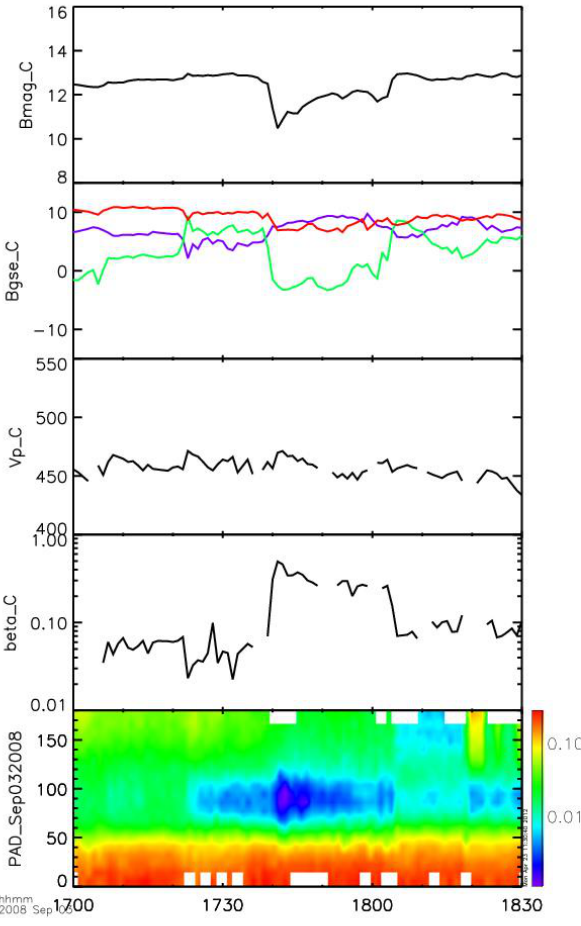
Fig. 3. ACE observation: zoom-in around the 90 ◦ pitch angle deple- tion. The panels give from top to bottom (a) magnetic field magni- tude, (b) magnetic field components in GSE, (c) solar wind speed, (d) plasma beta, and (e) the electron pitch angle spectrograms for the low-energy Electron Electrostatic Analyzer (EESA-L) on the SWEPAM instrument of ACE energy channel